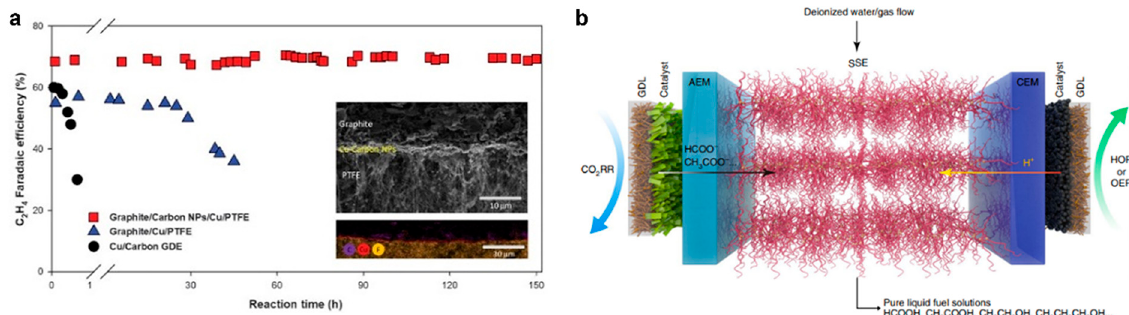
Figure 17. ( a ) A comparison of the selectivity towards CO 2 reduction to ethylene in 7 M KOH and the stability of a graph ‐ ite/carbon NPs/Cu/PTFE electrode and a traditional carbon ‐ based GDE. The insets show the cross ‐ sectional SEM and en ‐ ergy ‐ dispersive X ‐ ray spectroscopy mapping of the sample after 150 h of continuous operation (reproduced with permis ‐ sion from ref. [94], copyright 2018, AAAS); ( b ) a schematic illustration of a CO 2 reduction cell with a solid electrolyte. The SSE is either an anion or cation conductor (reproduced with permission from ref. [45], copyright 2019, Springer Nature).